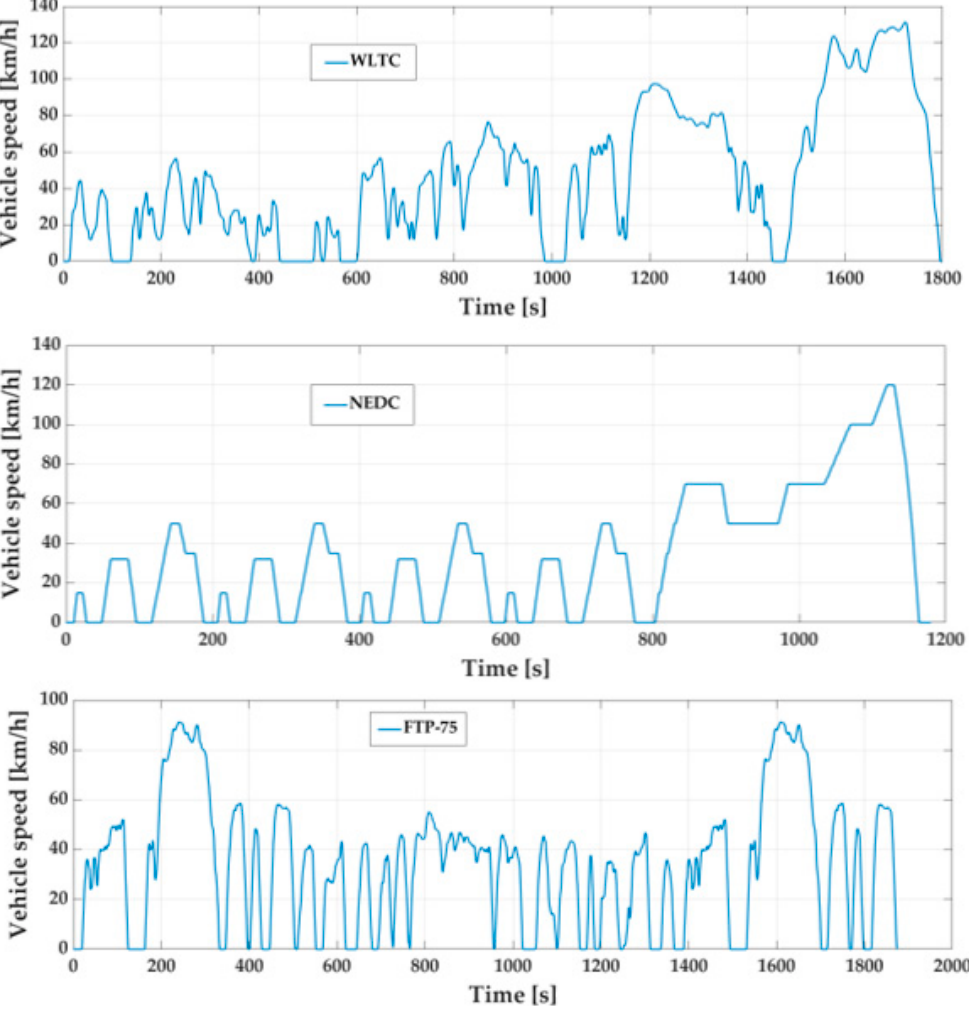
Figure 5. Vehicle speed vs. time for WLTC-Class 3, NEDC and FTP.